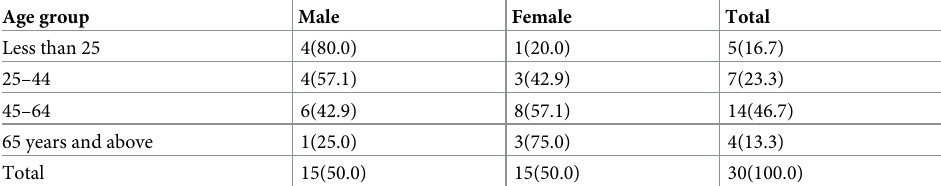
Table 2. Age and sex distribution of in-depth